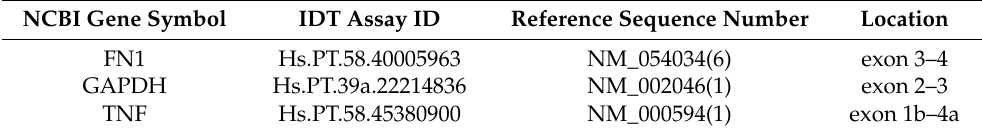
Figure S5: The western blots for phospho-p44/42 in Figure S4 were quantitated, Figure S6: Impact of conditioned media controls on ovarian cancer cell morphology, Figure S7: RAW 264.7 (mouse) macrophages induce TnTs in mouse ovarian cancer cells, and Figure S8: Mitochondria are present in OVCA429 membrane projections initiated by